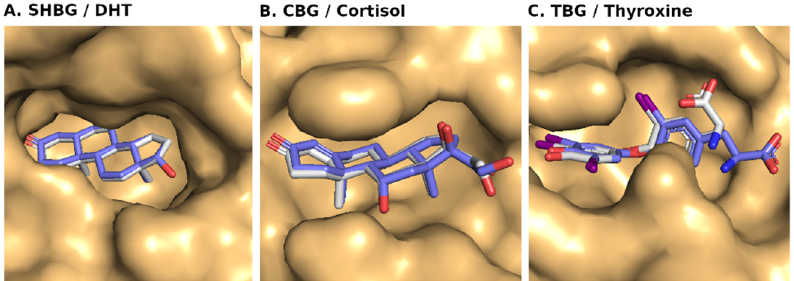
Figure 2. Self-docking analyses of the native ligands, i.e., dihydrotestosterone (DHT), cortisol, and thyroxine, respectively, for sex-hormone-binding globulin (SHBG), corticosteroid-binding globulin (CBG), and thyroxin-binding globulin (TBG). The ligand binding sites of the proteins are shown as a surface with light orange color. The docked pose of the native ligand is with a backbone colored in blue, whereas the original bound pose is with a backbone in white. Table 1. Self-docking analyses of the native ligands (dihydrotestosterone, cortisol, and thyroxine) for sex-hormone-binding globulin (SHBG), corticosteroid-binding globulin (CBG), and thyroxin-binding globulin (TBG). For the root-mean-square deviation (RMSD) calculation, the heavy atoms of ligands (excluding hydrogen atoms) were